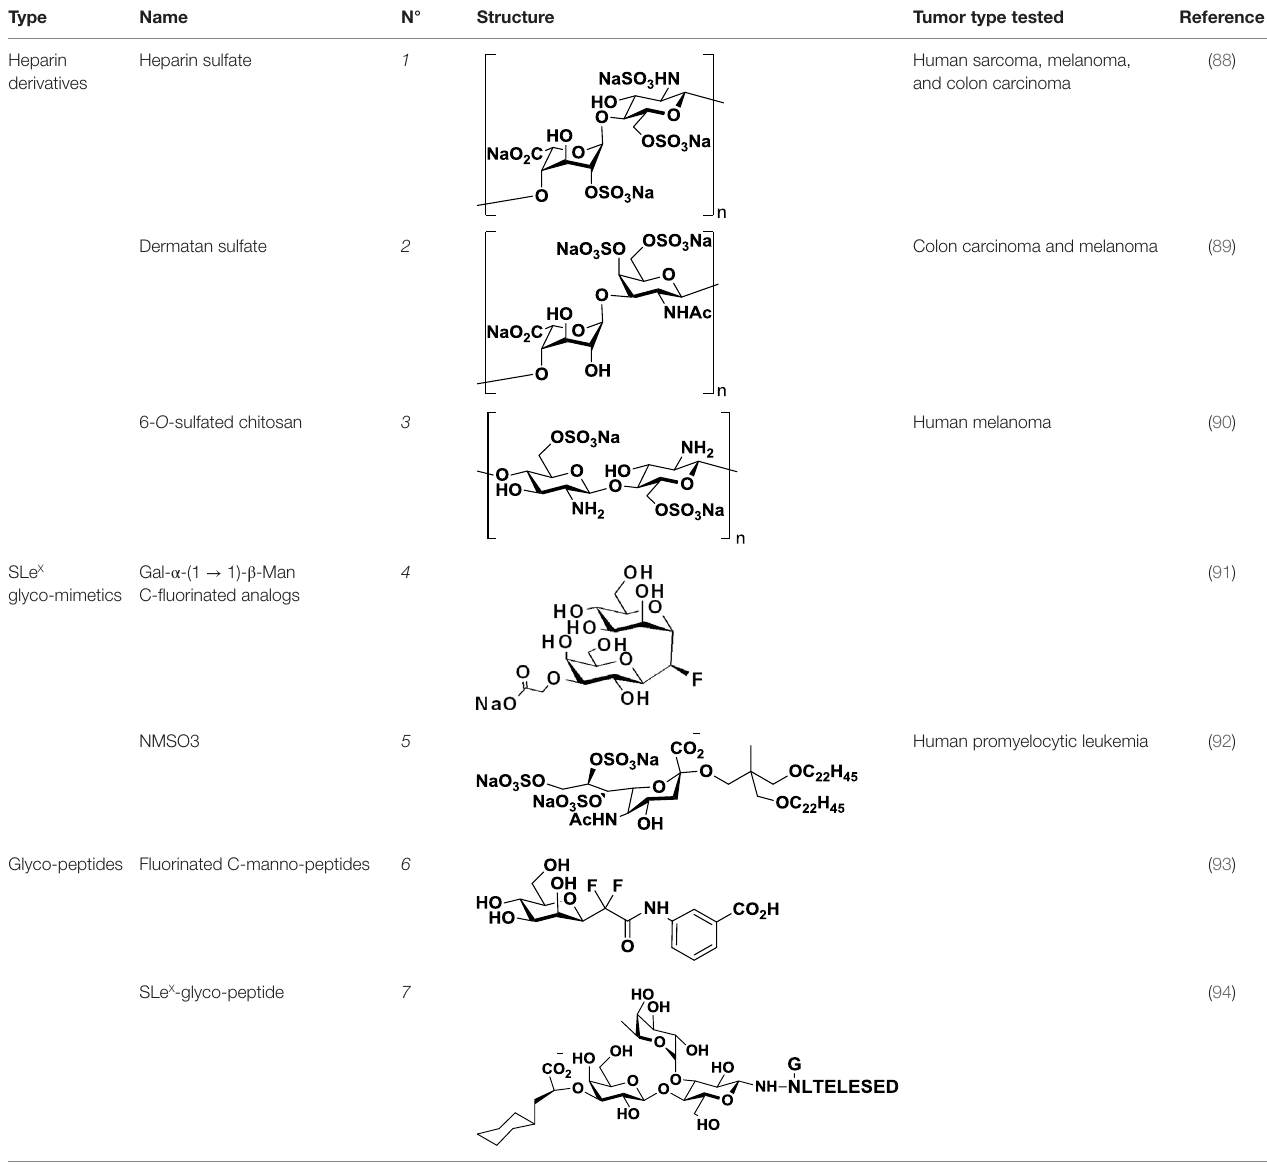
TABLe 1 | Structure and clinical applications of different anti-selectin agents described in this